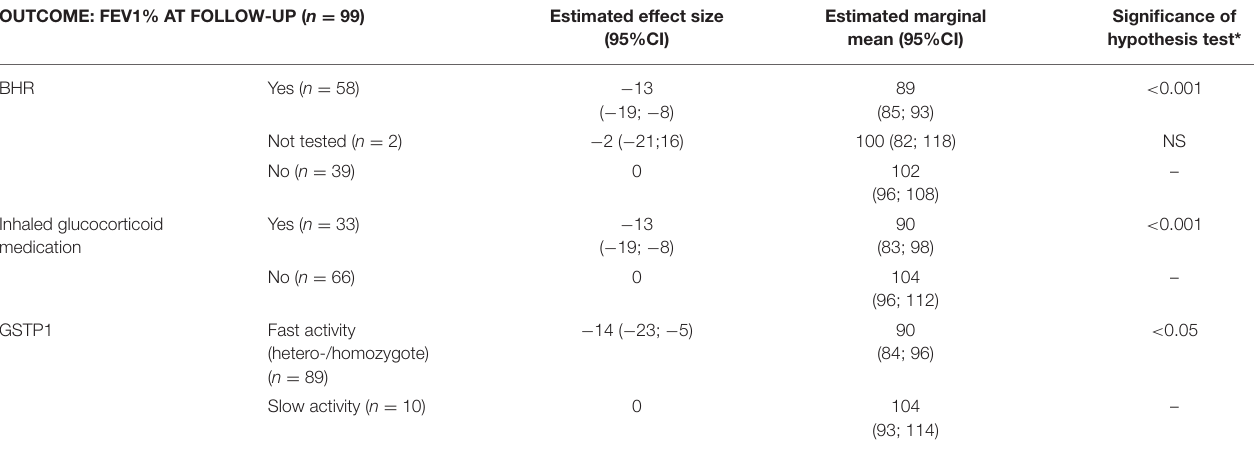
TABLE 6 | The effect of significant predictive factors on follow-up FEV1% in the regression model. OUTCOME: FEV1% AT FOLLOW-UP ( n =